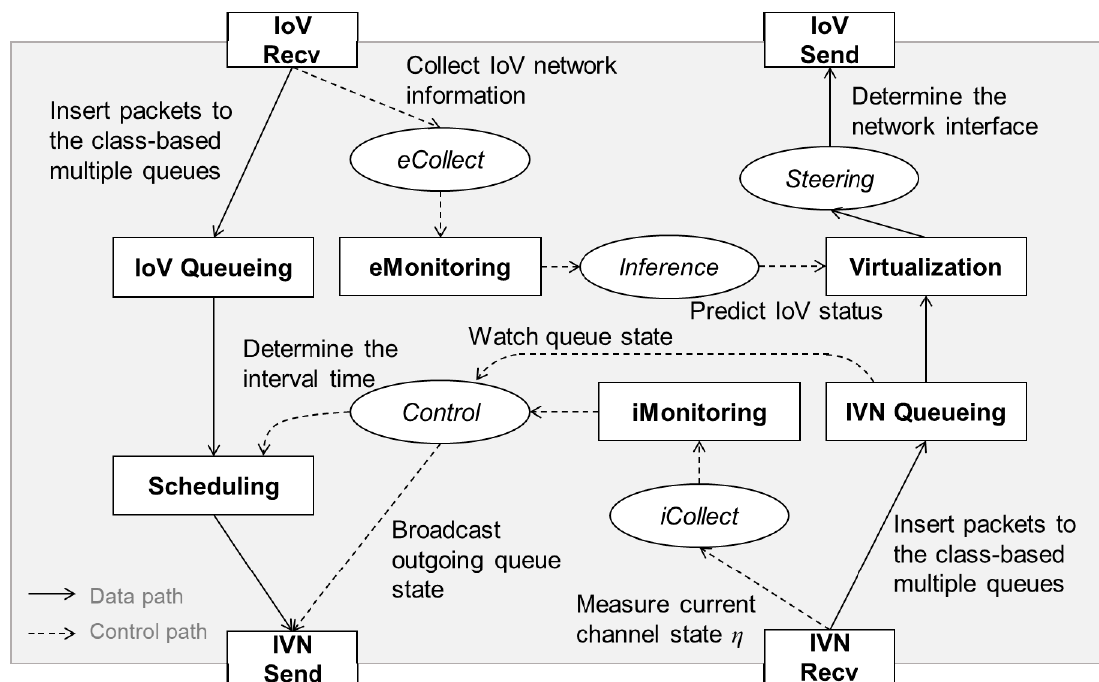
Figure 5. The proposed IoV access gateway (A ‐ GW) system